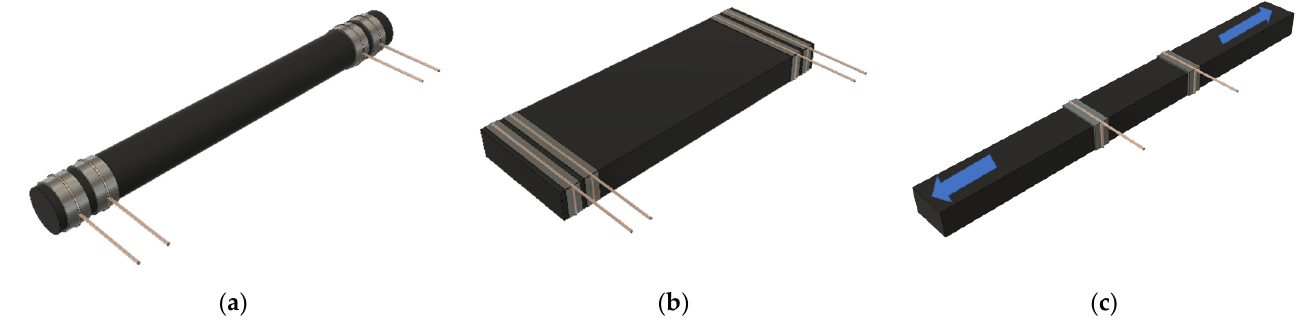
Figure 2. Specimens for electrical conductivity measurements in ( a ) extruded filaments and ( b ) hot- pressed samples, and ( c ) electromechanical tensile tests.